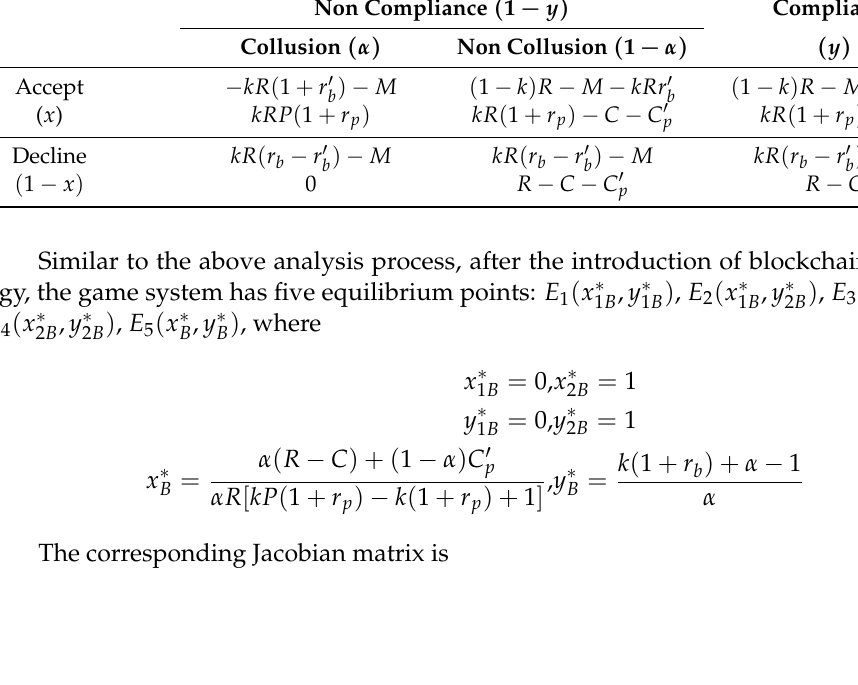
Table 3. The return matrix after introducing blockchain technology.